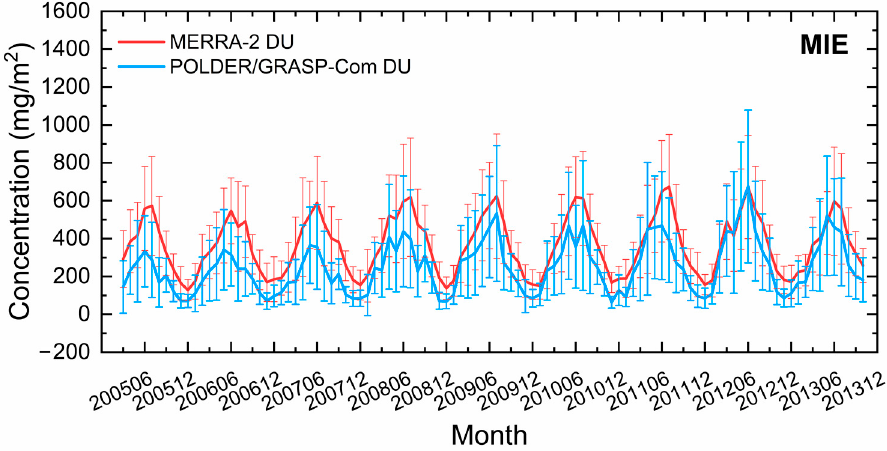
Figure 5. Same as Figure 3, but for Middle East (MIE) Figure 5 . Same as Figure 3, but for Middle East (MIE) region.